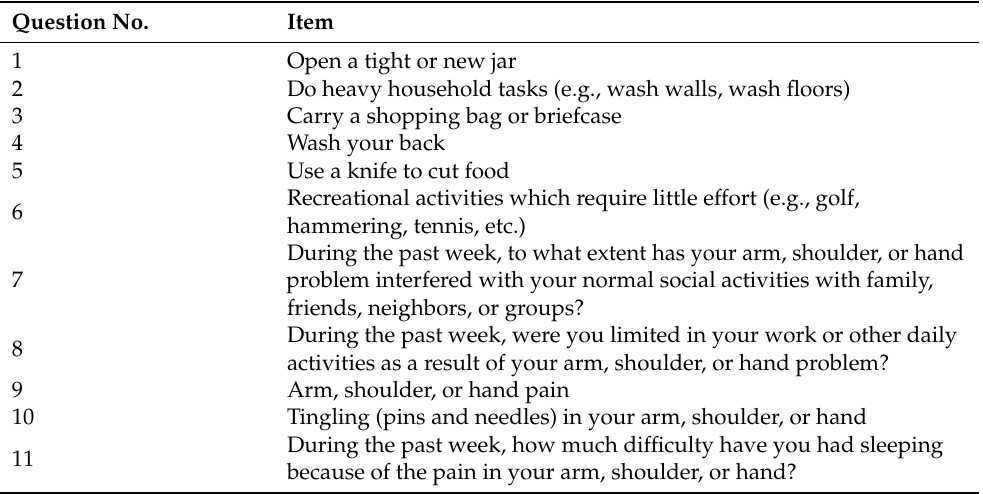
Table 2. The QuickDASH questionnaire consists of eleven items with a score of 1 to 5 points for each item.